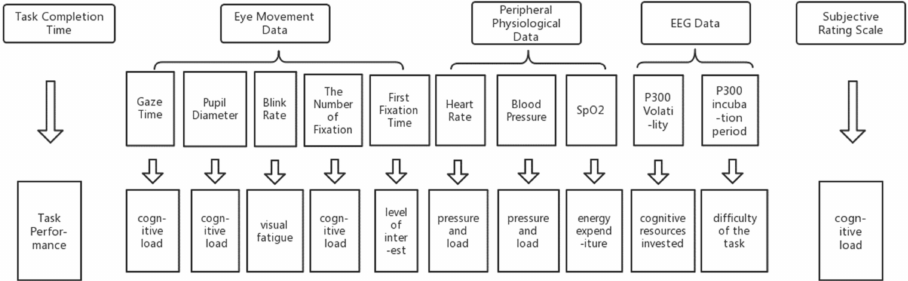
Figure 14. Data Types and Contributions.